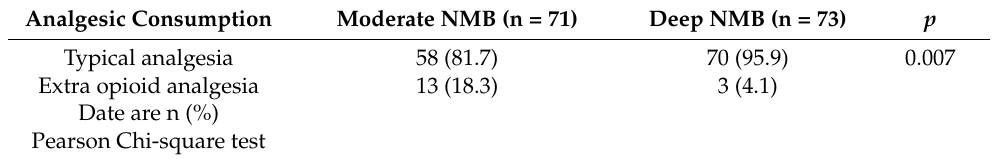
Table 5. Postoperative analgesic